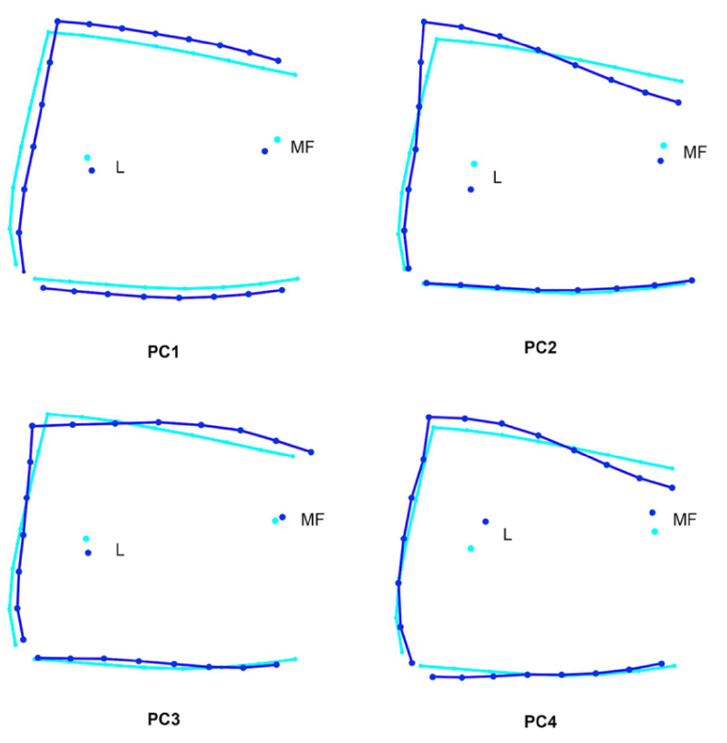
Figure 5. Three-dimensional morphogeometric analysis. Principal components of the interforaminal hemimandible region from a lateral view. Light blue line: procrustes fit; blue line: PCs.